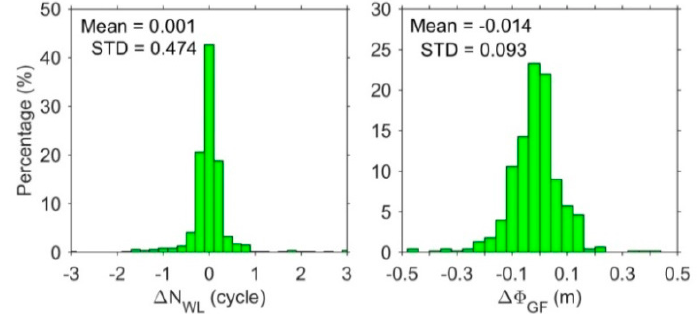
HKST station on 22 February 2016.